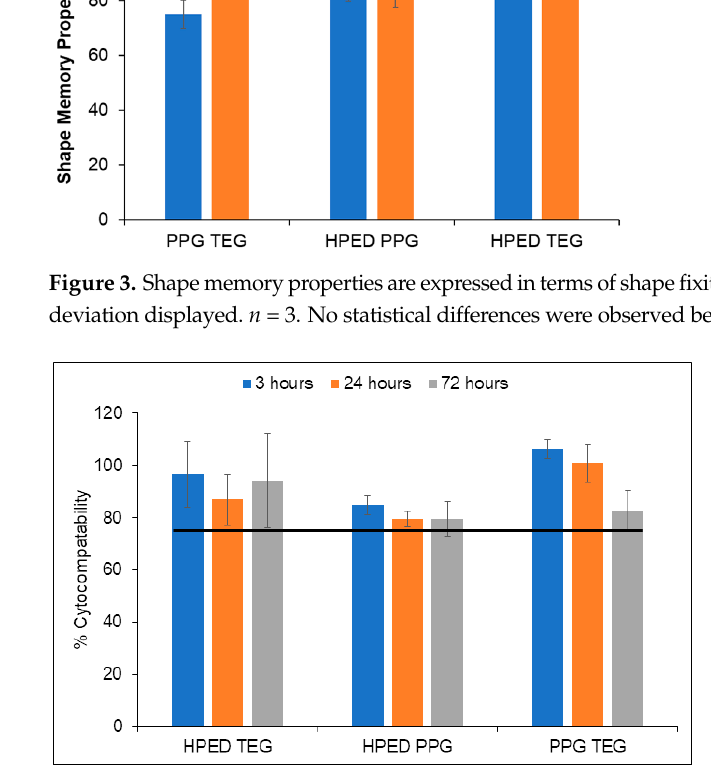
Figure 3. Shape memory properties are expressed in terms of shape fixity and recovery. Mean ± standard deviation displayed. n = 3. No statistical differences were observed between formulations.